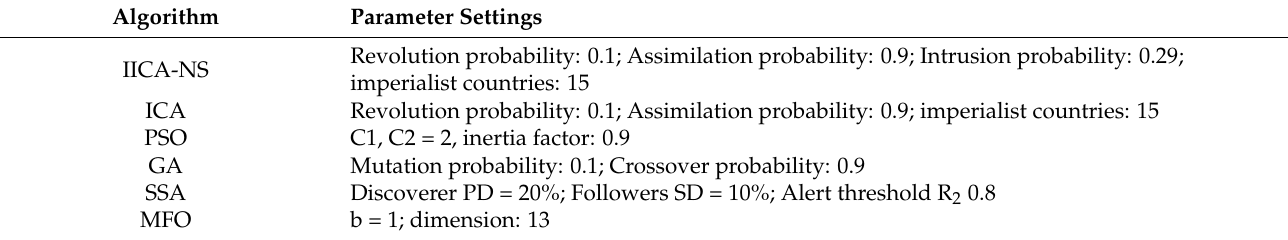
Table 7. Details of algorithm